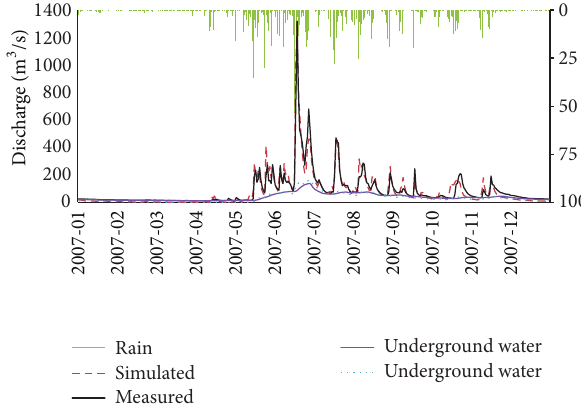
Figure 5: XAJ model validation phase (2006). Measured and simu- lated discharge, the groundwater runoff separated from the hydro- graph and calculated by Xin’anjiang model, and catchment average rainfall time series.